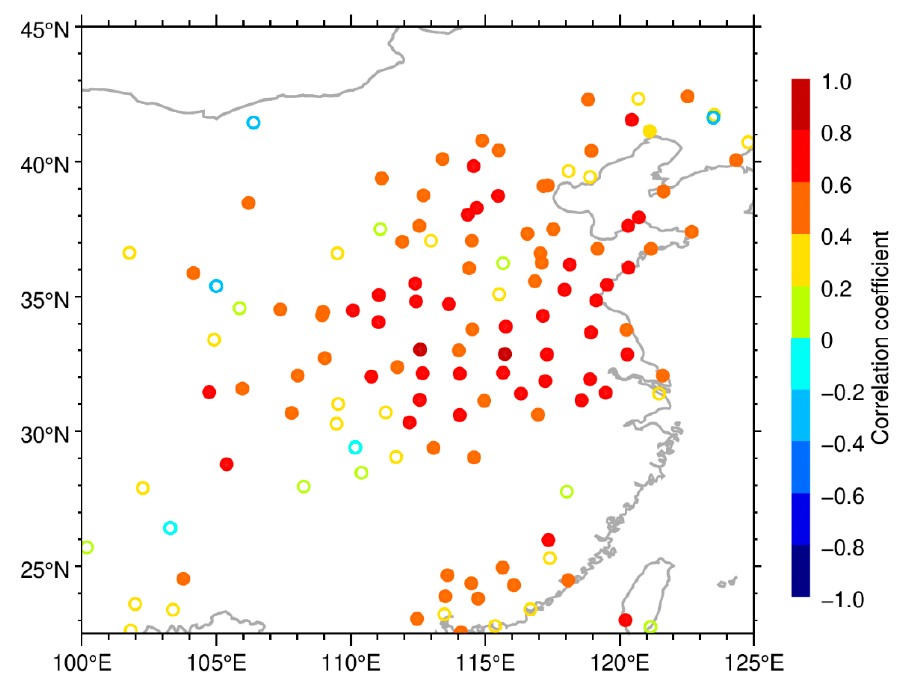
Figure 13. Correlation coefficients between the average daily visibility and V c during 30 December 2012 to 20 January 2013 over central and eastern China. Solid dots indicate values that are statistically significant at 95% confidence level or greater, while open circles indicate values that are not. Out of the 130 sites, 94 (~72%) have a positive correlation, which is statistically significant at a 95% confidence level or greater.